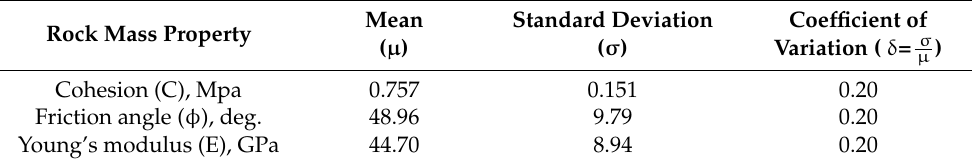
Table 2. Random properties for rock mass I